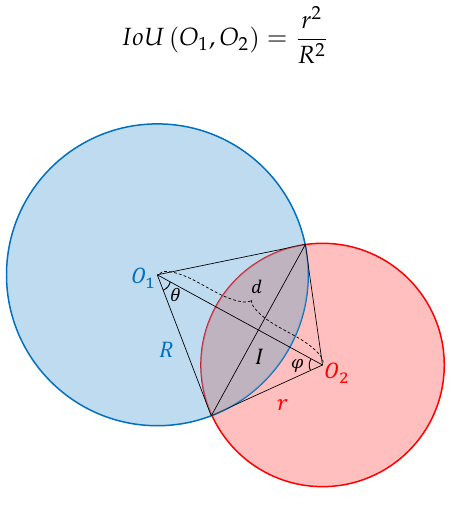
Figure 8. Overlap of two